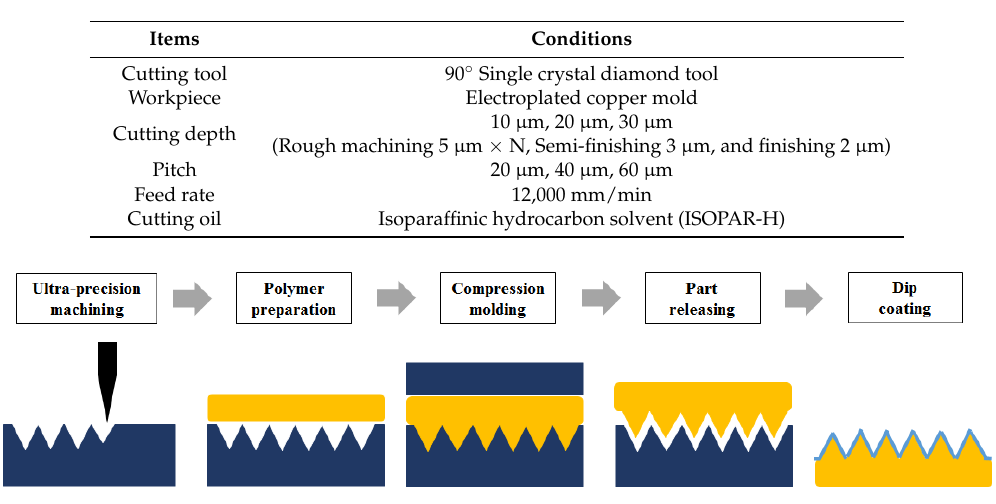
Figure 1. Design of the groove patterns and the images of the single crystal diamond tool and its tip. Table 1. Machining conditions for the fabrication of the groove patterns.